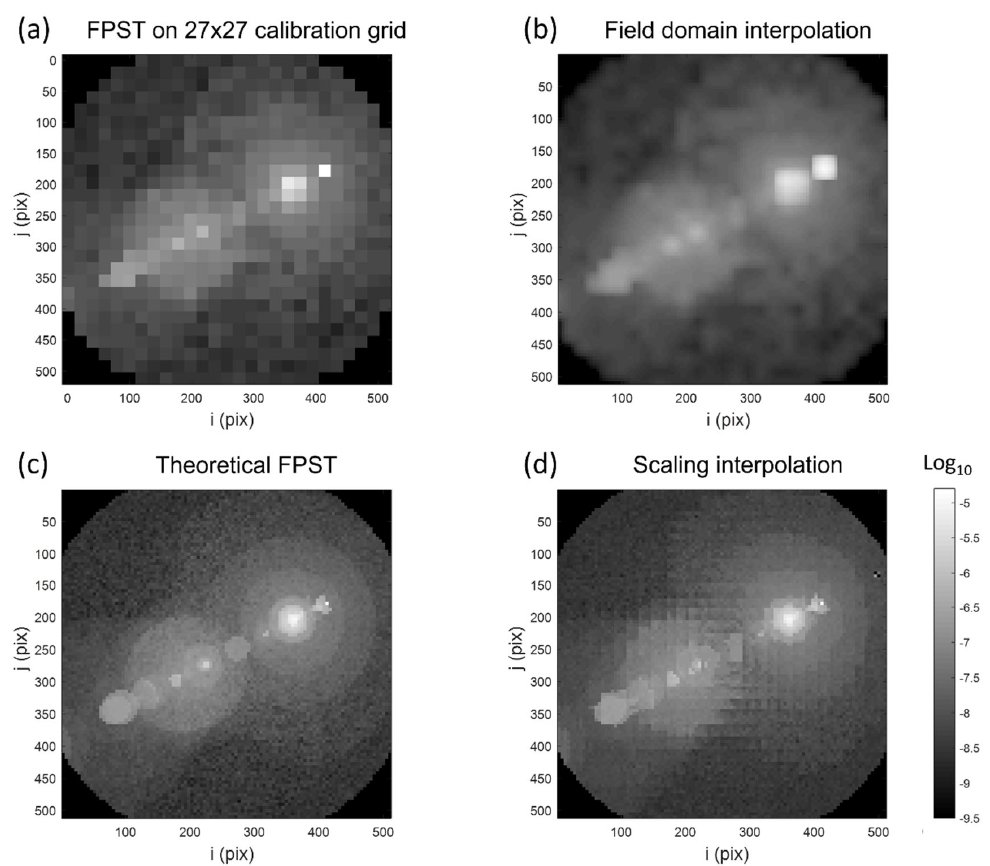
Figure 8. FPST x,y (i,j) at pixel ( x,y ) = (359,205). ( a ) FPST on a 27 × 27 grid calibration grid. ( b ) FPST interpolated in the field domain from the 27 × 27 grid to a high ‐ resolution grid. ( c ) Theoretical FPST on the high ‐ resolution field grid. ( d ) FPST on the high ‐ resolution grid, obtained by scaling interpolation with SPST maps calibrated over the grid of Figure 10.